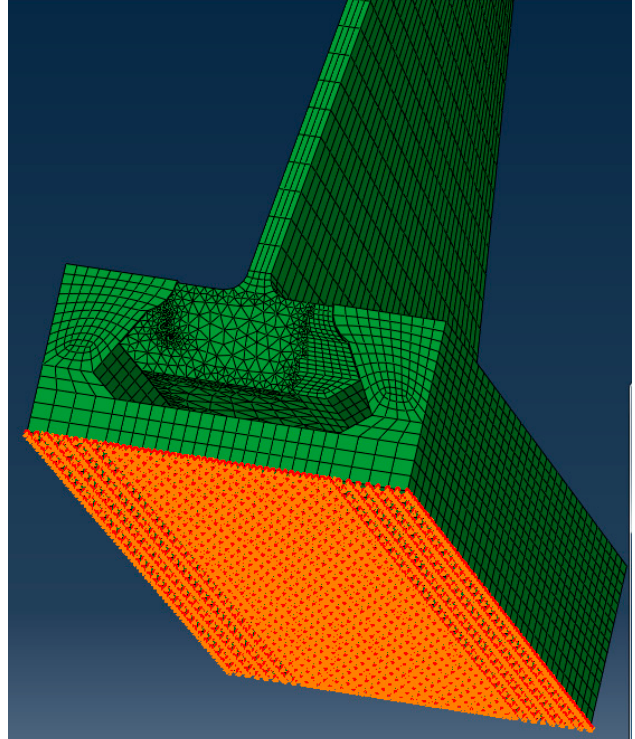
Figure 6. Boundary conditions at the bottom surface of the disc block.